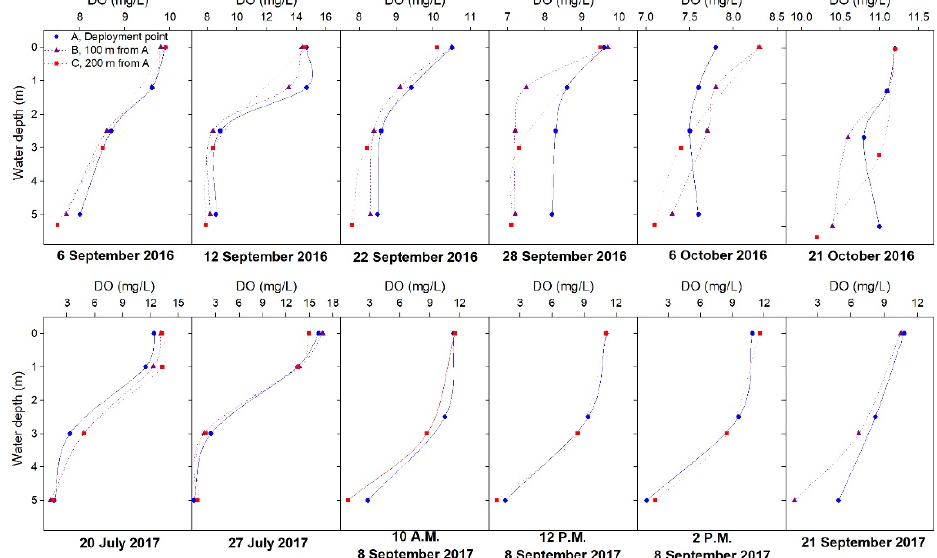
Figure 3. Vertical profiles of dissolved oxygen concentrations in 2016 and 2017 seasons. A—The CWCS deployment site (site A), B—100 m away from the deployment site (site B), and C—200 m away from the deployment site (site